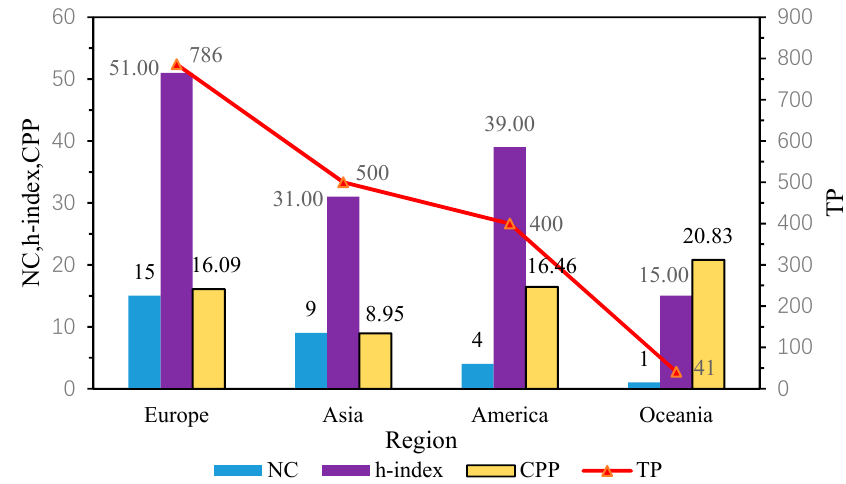
Figure 2. Regions that include the top 30 countries with the most publications. NC, Number of Countries; TP, Total Publications; CPP, Citations Per Paper.